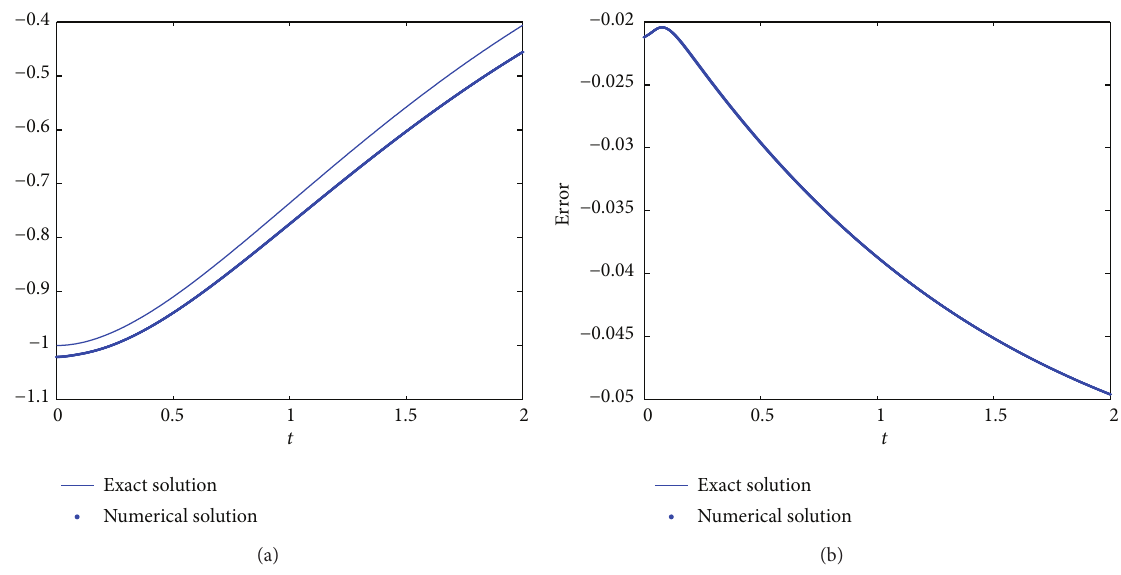
̂𝑓(𝑡) ̂𝑓(𝑡) (a), the error 𝑓(𝑡) − (b) with 𝛾 = 0.01 .